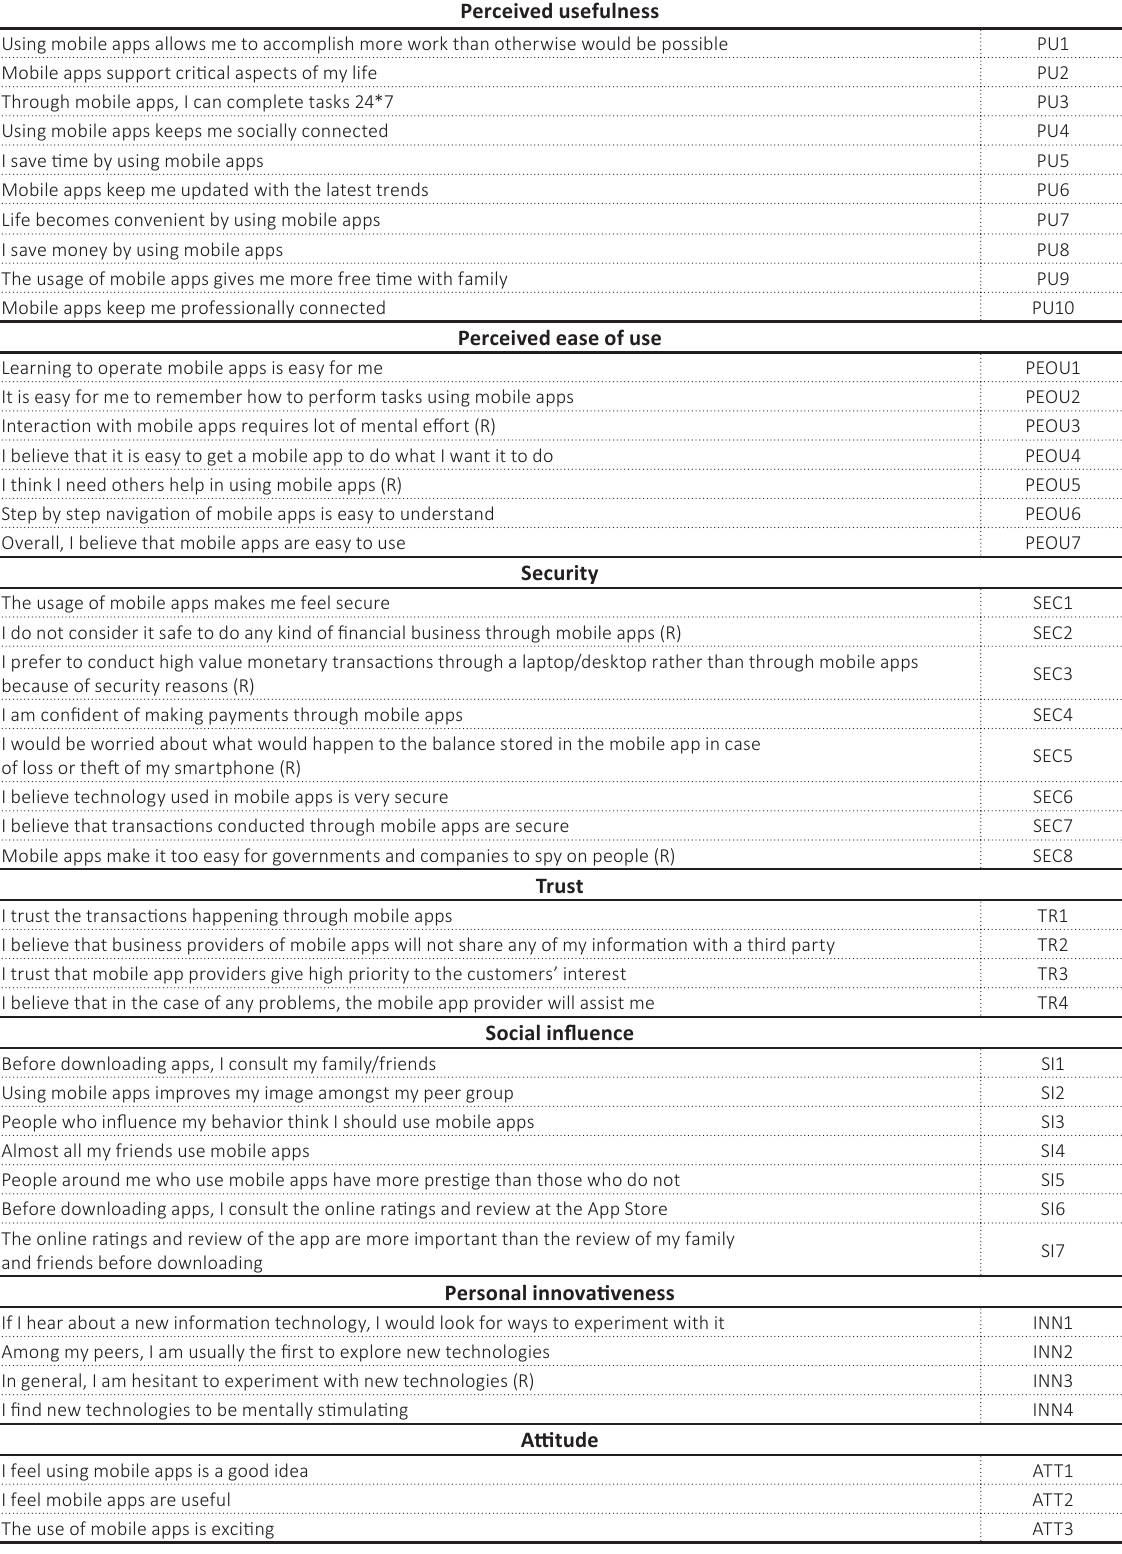
Table A1. Examining antecedents affecting Indian consumers’ adoption of mobile apps Perceived